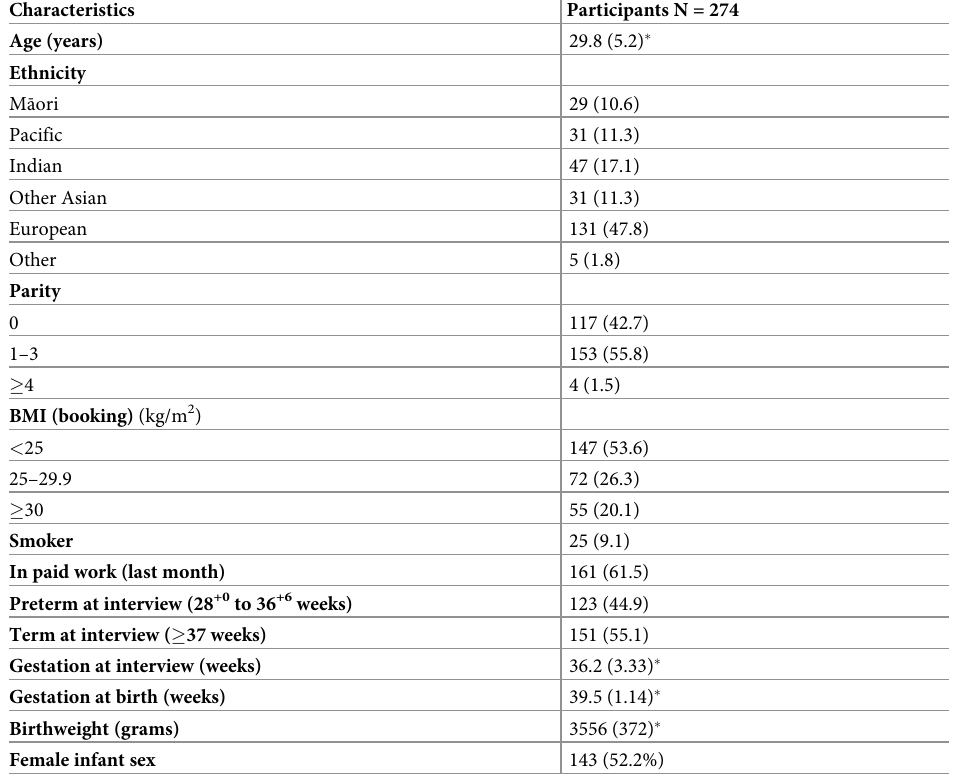
Table 1. Participant